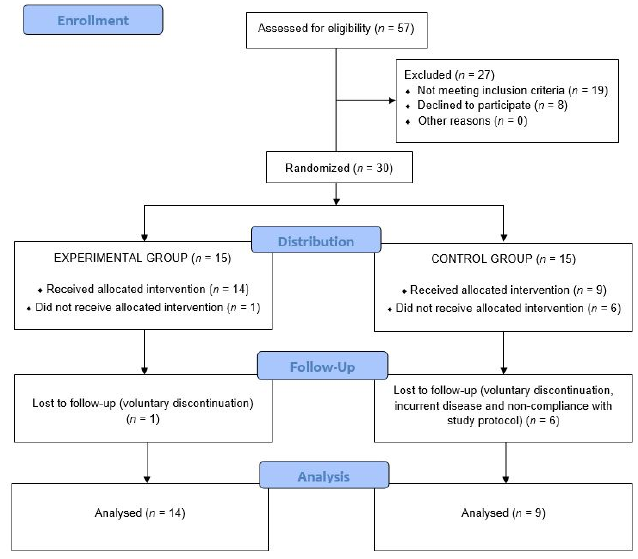
Figure 1. Flow chart of the study population.